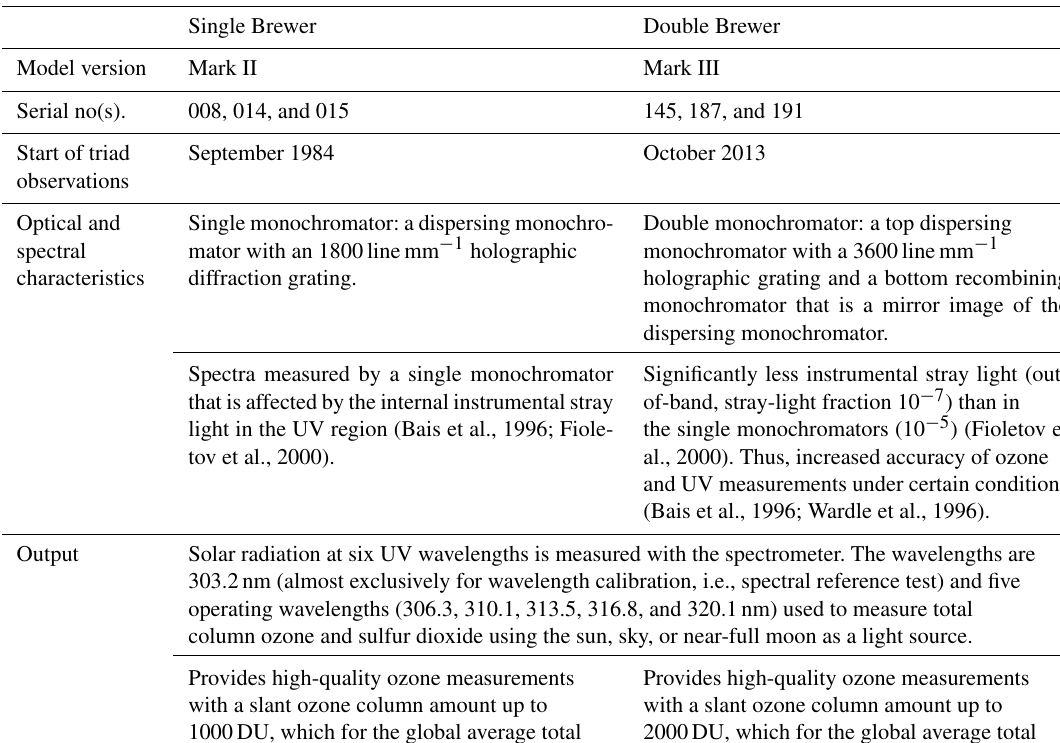
Table 1. Specific features of single- and double-Brewer reference triads. Single